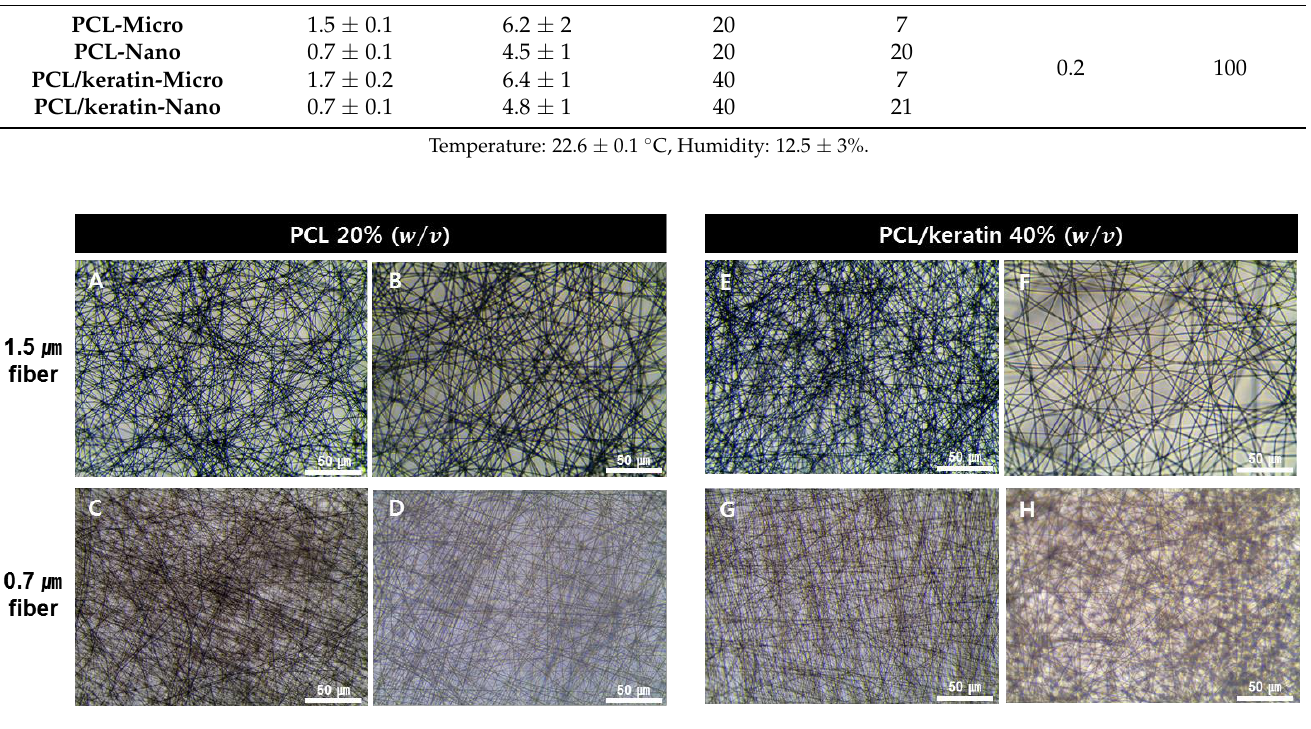
Figure 1. Electrospun layers with and without keratin. ( A , B ) PCL scaffold with 1.5 μ m fibers (7 kV). ( C , D ) PCL scaffold with 0.7 μ m fibers (20 kV). ( E , F ) PCL/keratin scaffold with 1.5 μ m fibers (7 kV). ( G , H ) PCL/keratin scaffold with 0.7 μ m fibers (21 kV). Table 1. Fiber diameters and pore sizes of 20% ( w / v ) PCL and 40% ( w / v ) PCL/keratin with respect to the electrospinning process parameters.